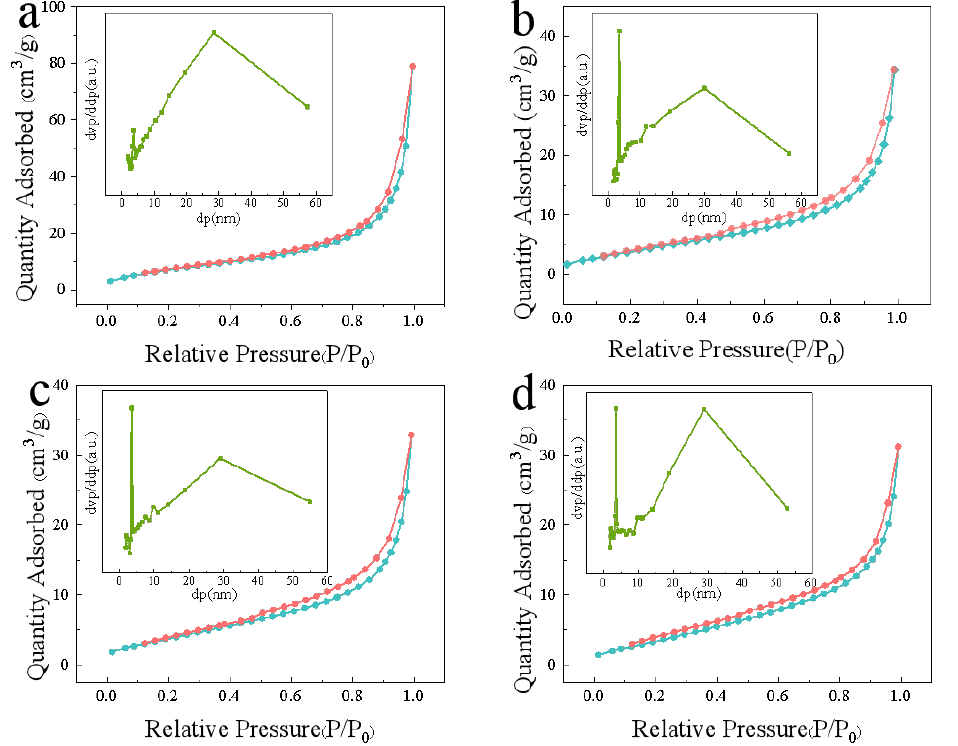
Figure 3. N 2 adsorption/desorption isotherms of ( a ) Ni-MOFs, ( b ) NiCo-MOFs, ( c ) NiMn-MOFs, and ( d ) NiCu-MOF. Pore size distribution is shown in the embedded diagram.